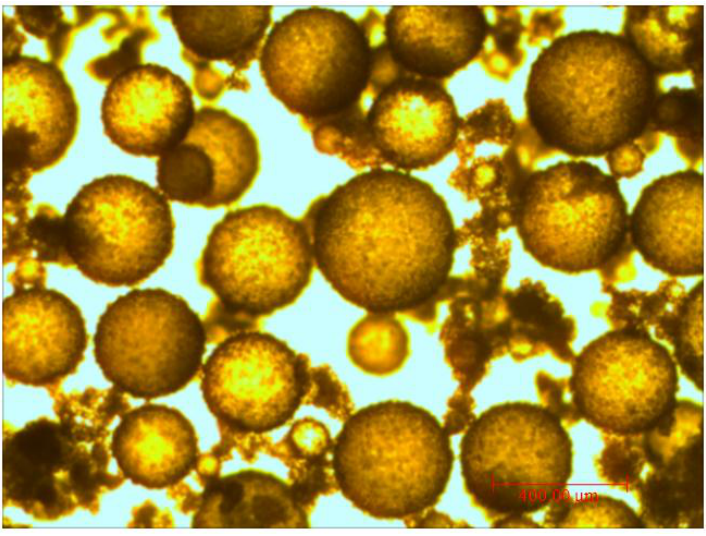
Figure 3. The morphology of newly-manufactured MPCM.